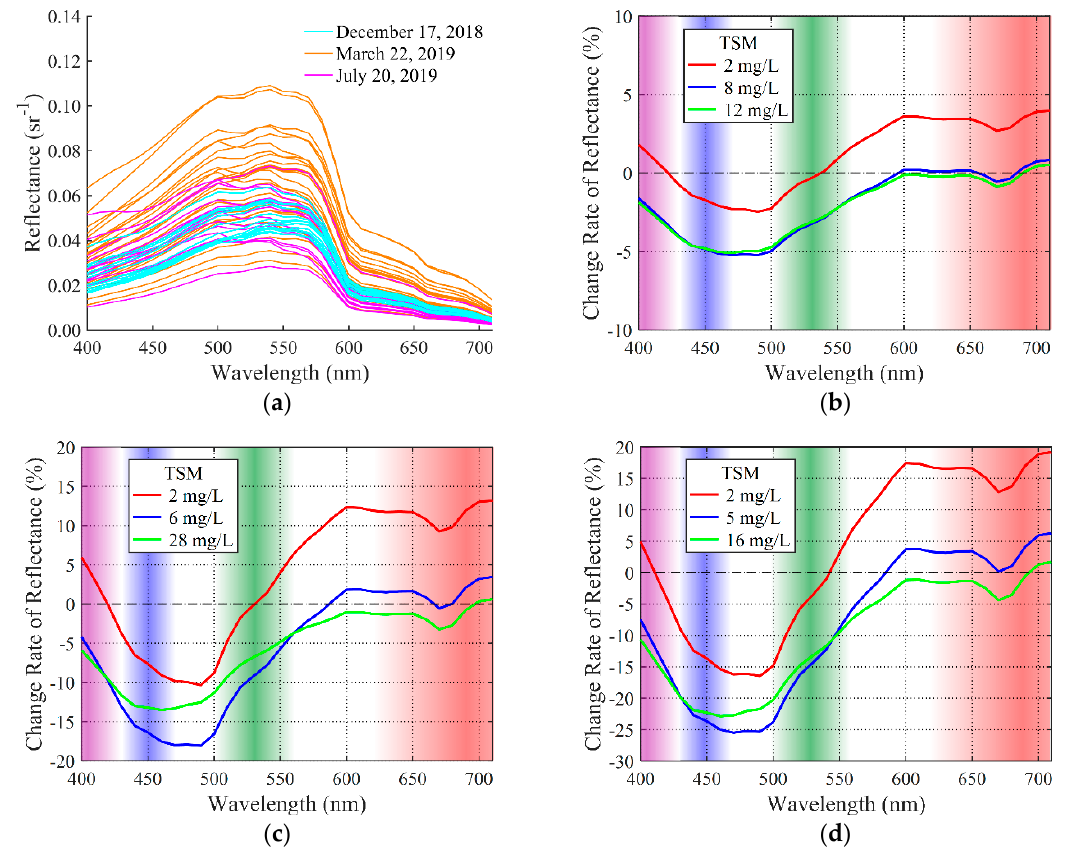
Figure 8. ( a ) The simulated water reflectance by the bio-optical models based on the measurements and empirical parameters; the change rates of the water reflectance when Chl-a concentrations rise from the measured minimum to the measured maximum with di ff erent total suspended matter (TSM) concentrations: ( b ) from 0.8409 to 1.1372 mg / m 3 on 17 December 2018; ( c ) from 0.1007 to 0.8406 mg / m 3 on 22 March 2019; ( d ) from 0.2801 to 1.5477 mg / m 3 on 20 July 2019.